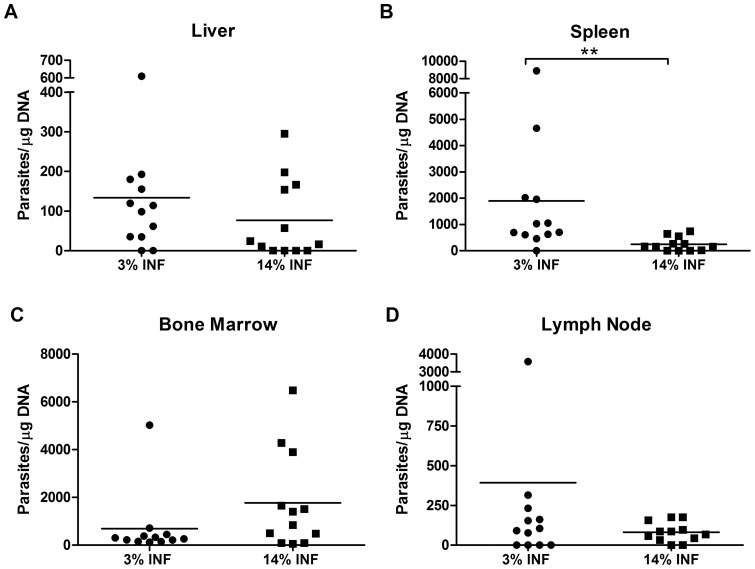
Quantitative distribution of L. infantum in malnourished and well-nourished hamsters.The parasite burden was quantified on the (A) liver, (B) spleen, (C) bone marrow, and (D) lymph node. Data represent means ± SD of 12 animals per group of a representative experiment of two independent assays. Splenic parasite loads were significantly increased in malnourished animals. The presence of parasites in blood was detected only in hamsters fed the 3% protein diet (2/12, data not shown).